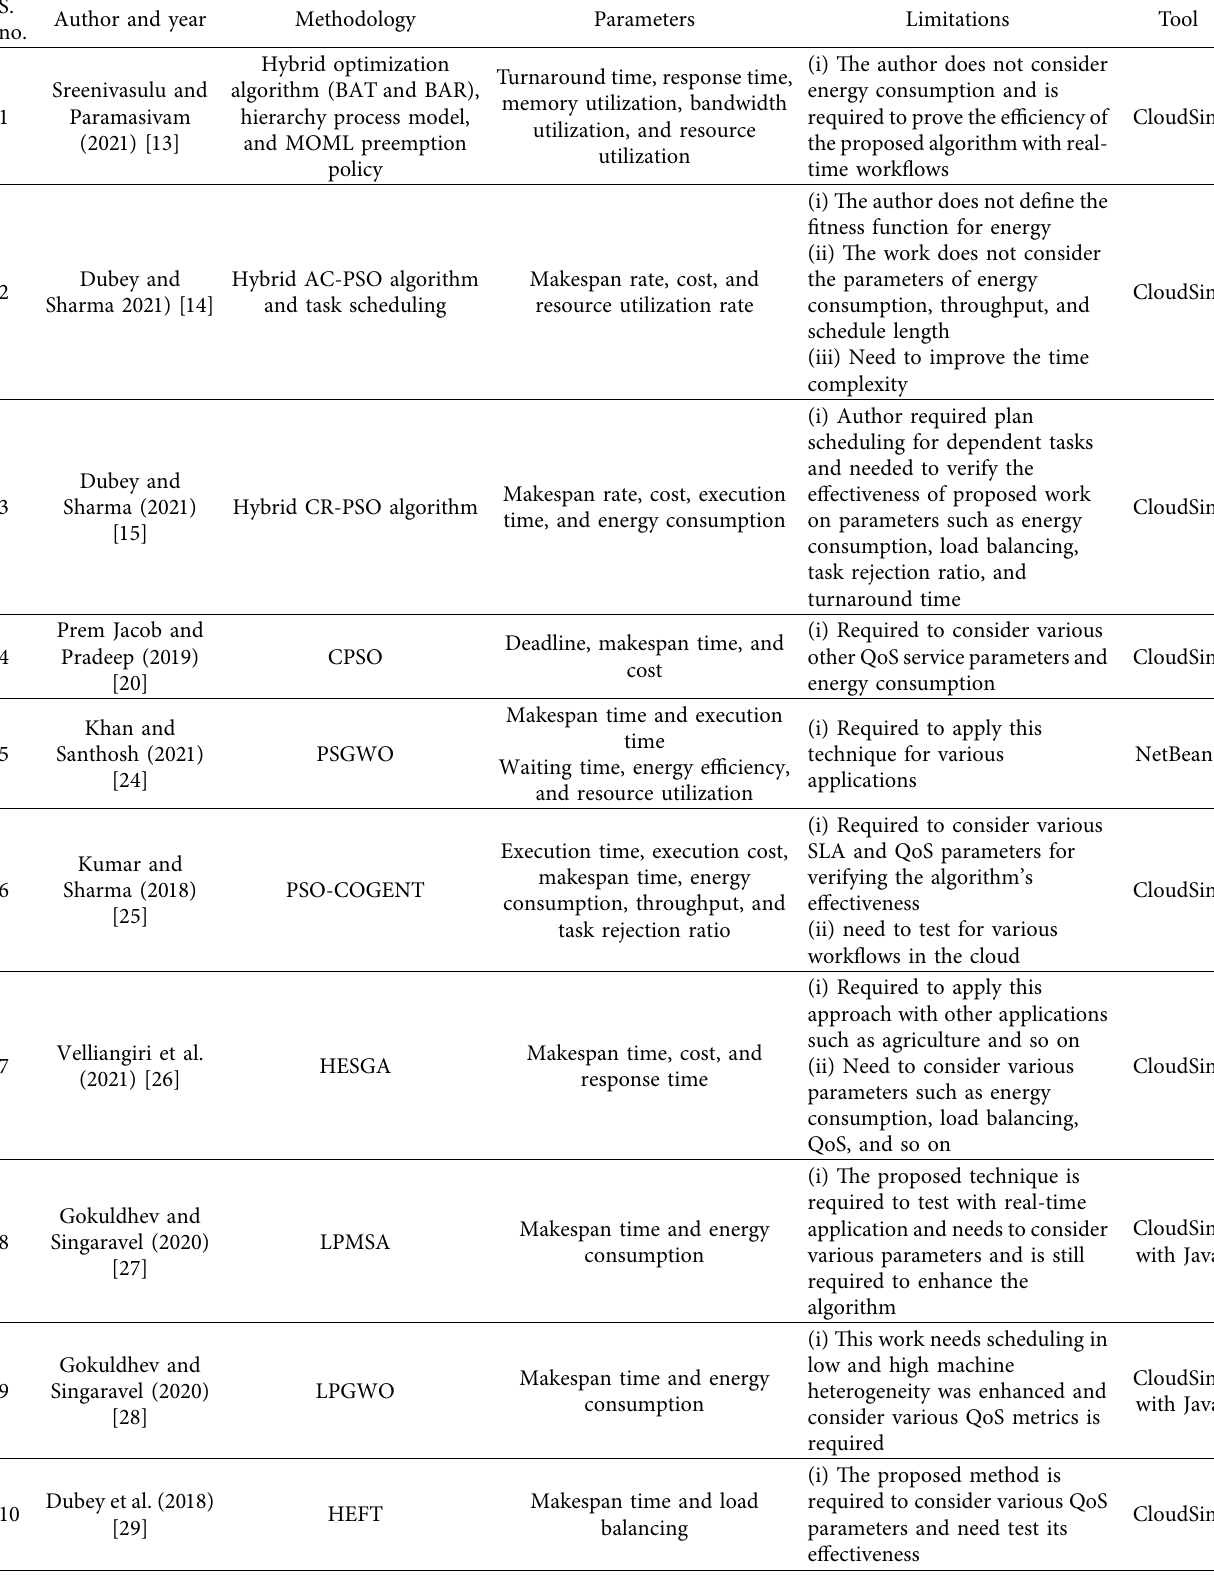
Table 1: iterature review of metaheuristic hybrid task scheduling algorithms with